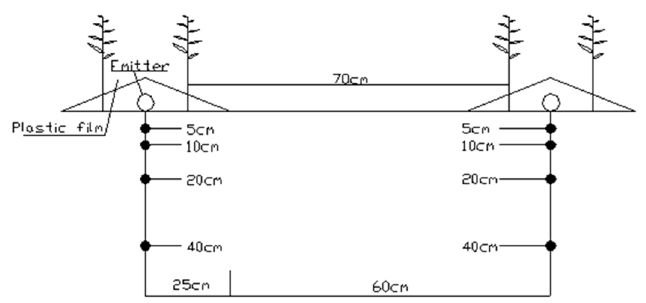
Figure 5. Mapping of soil temperature testing instruments.